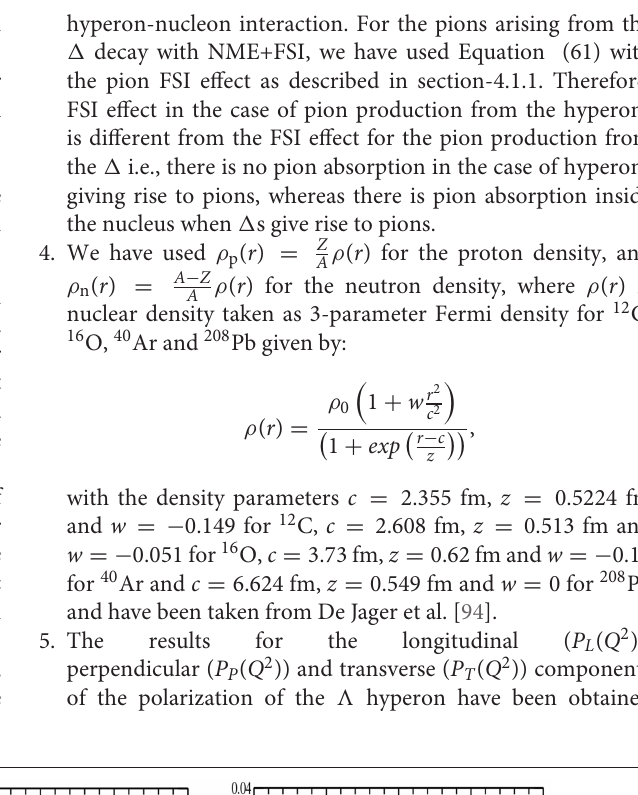
FIGURE 6 | P L ( Q 2 ) (left) , P P ( Q 2 ) (middle) , and P T ( Q 2 ) (right) for the process m µ 0, g 3 ( Q 2 ) = 0 (solid line) and m µ =